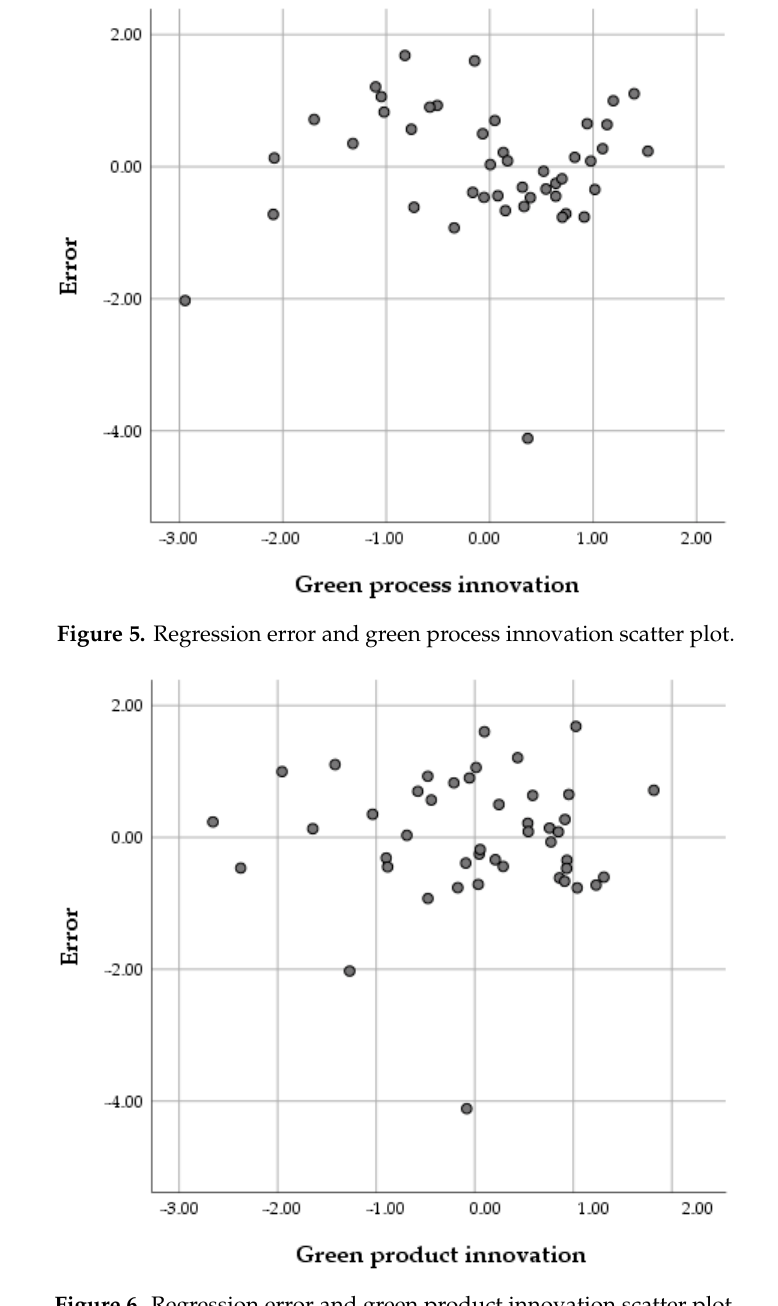
Figure 6. Regression error and green product innovation scatter plot.